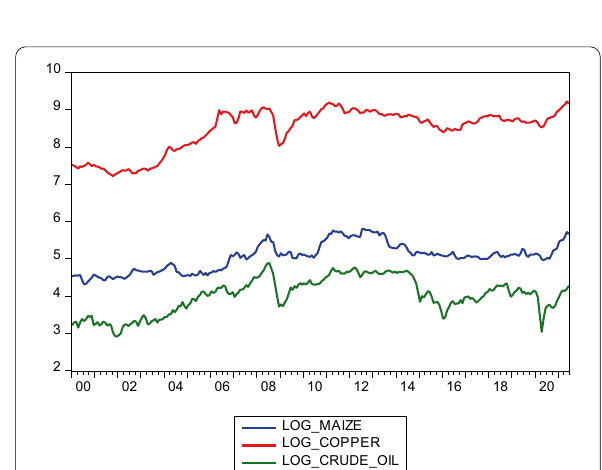
Fig. 2 Trend of crude oil, copper and maize prices (2000 to 2021)